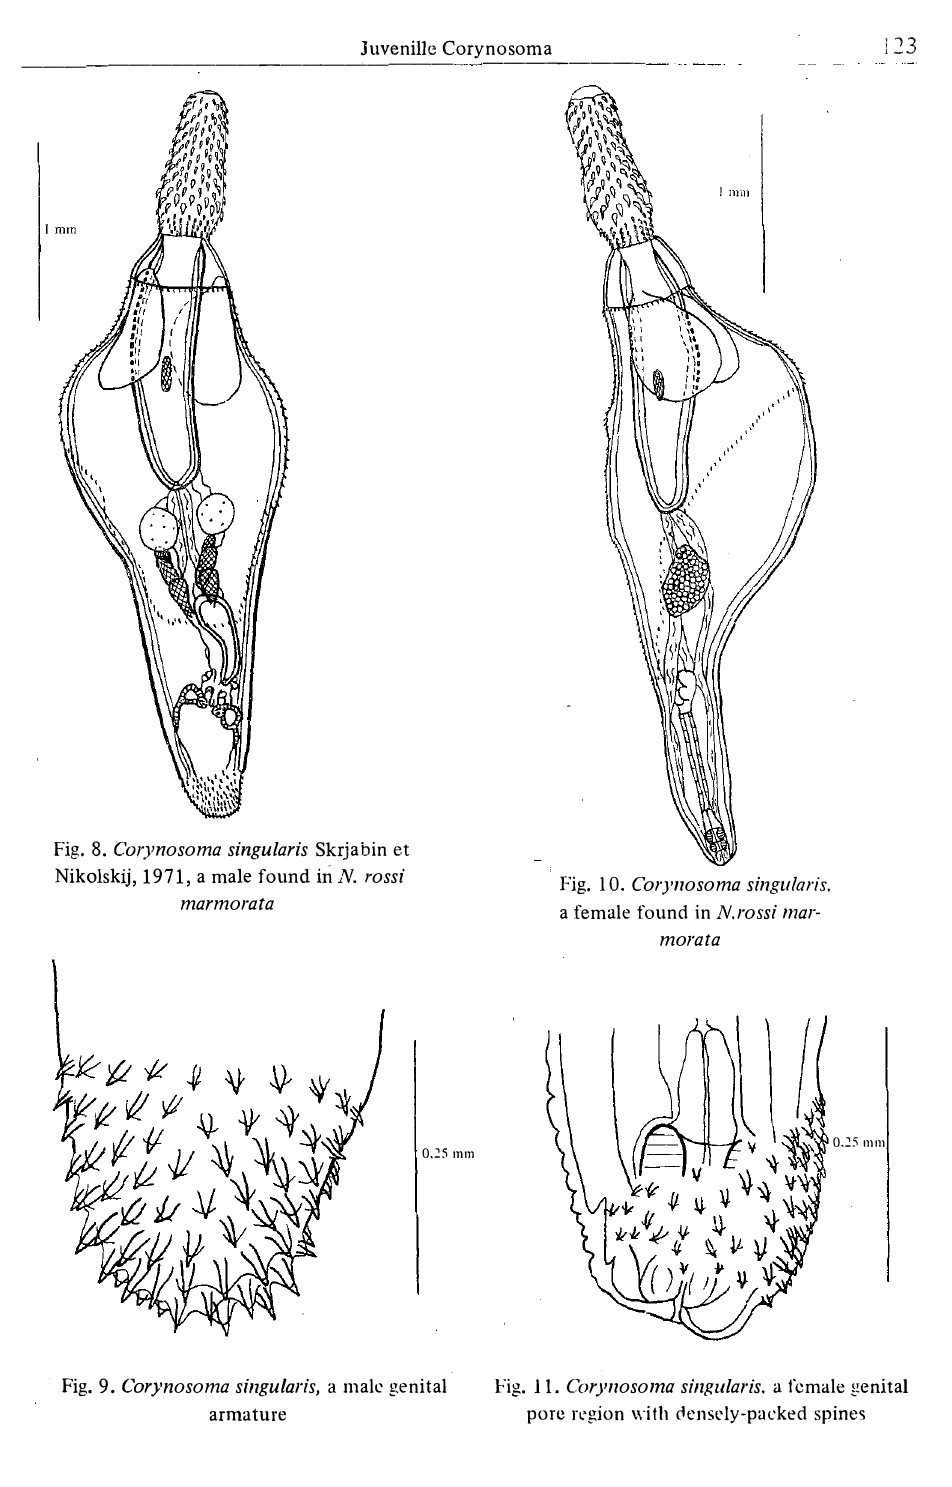
Fig. 11. Corynosoma singularis. a female tienital Fig. 9. Corynosoma singularis, a male genital pore r,'gion with clensl'iy-packed armature